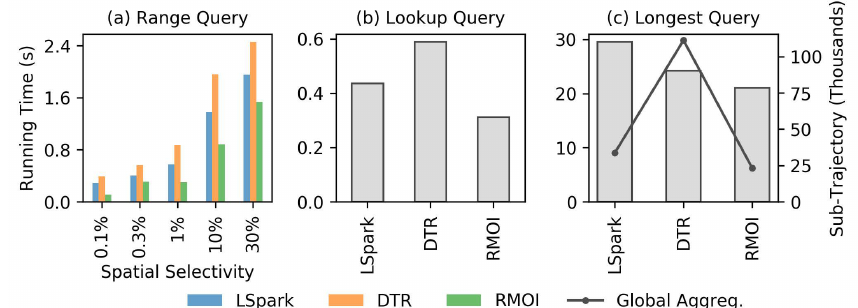
Figure 8. Average execution time for the UK + IE dataset with low resource availability on ( a ) range query, ( b ) lookup query, and ( c ) longest query.